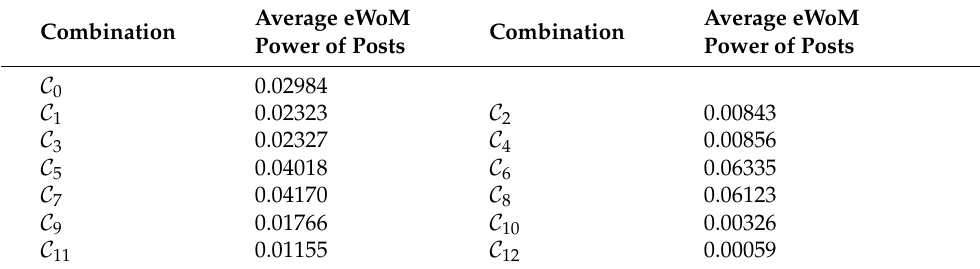
Table 6. Average eWoM Power of posts for the predefined weight